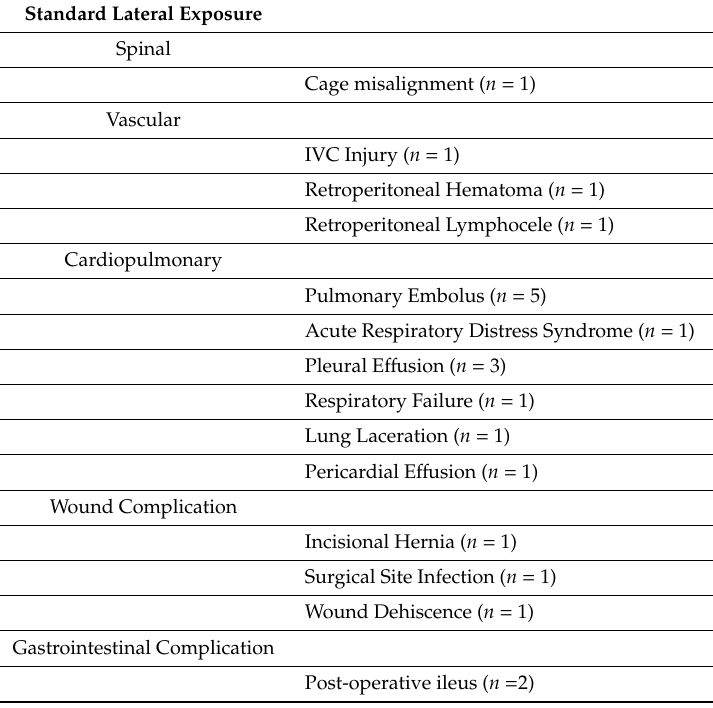
Table 5. Complication types in the standard open